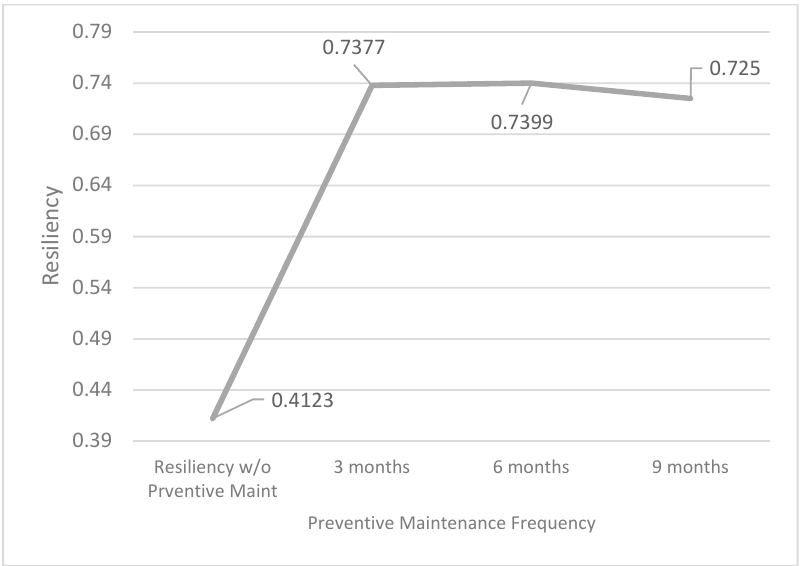
Figure 10. System resilience index with preventive maintenance on critical equipment .